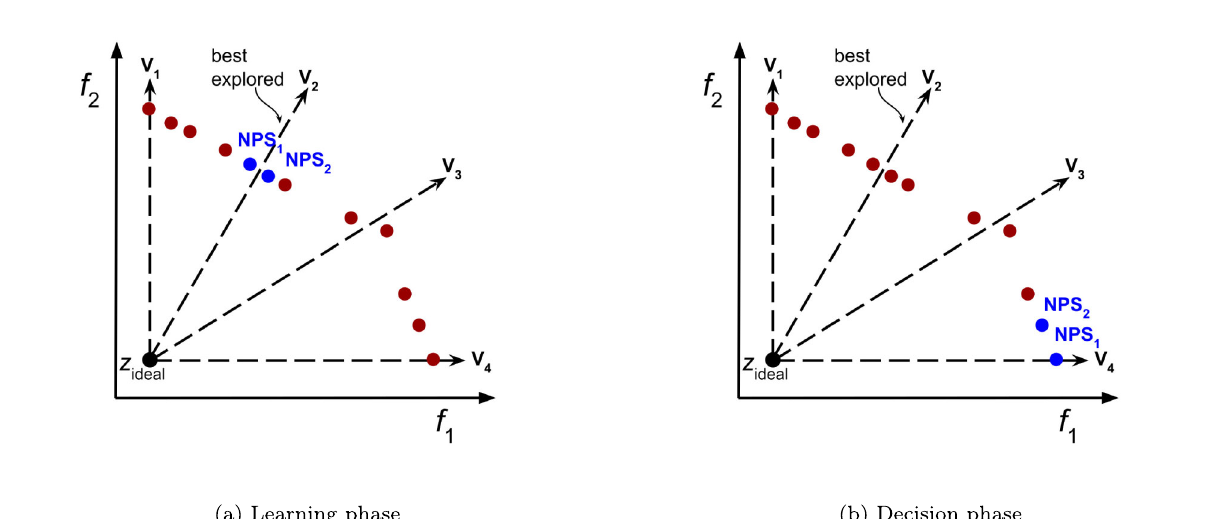
Performing pairwise